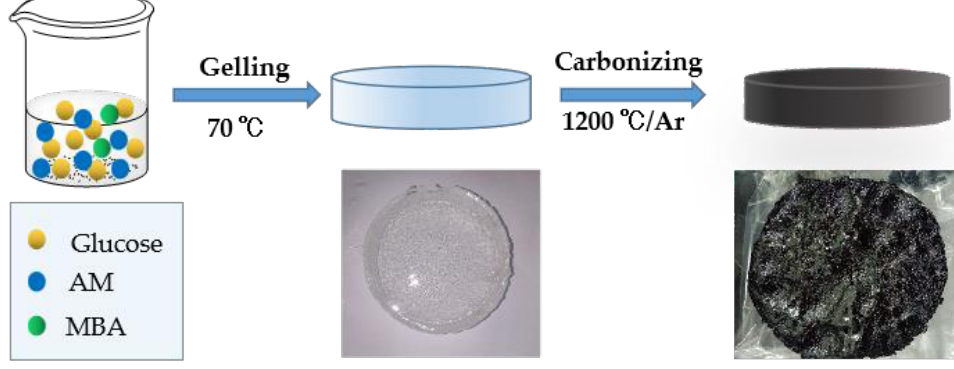
Figure 1. Process of sugar-derived carbon via hydrogel.